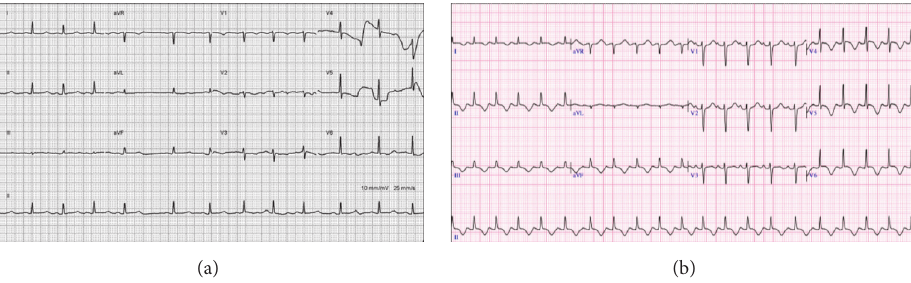
Figure 1: (a) Initial electrocardiogram (ECG) of the patient at the emergency department (ED). (b) Follow-up ECG at the ward 24 hours later.